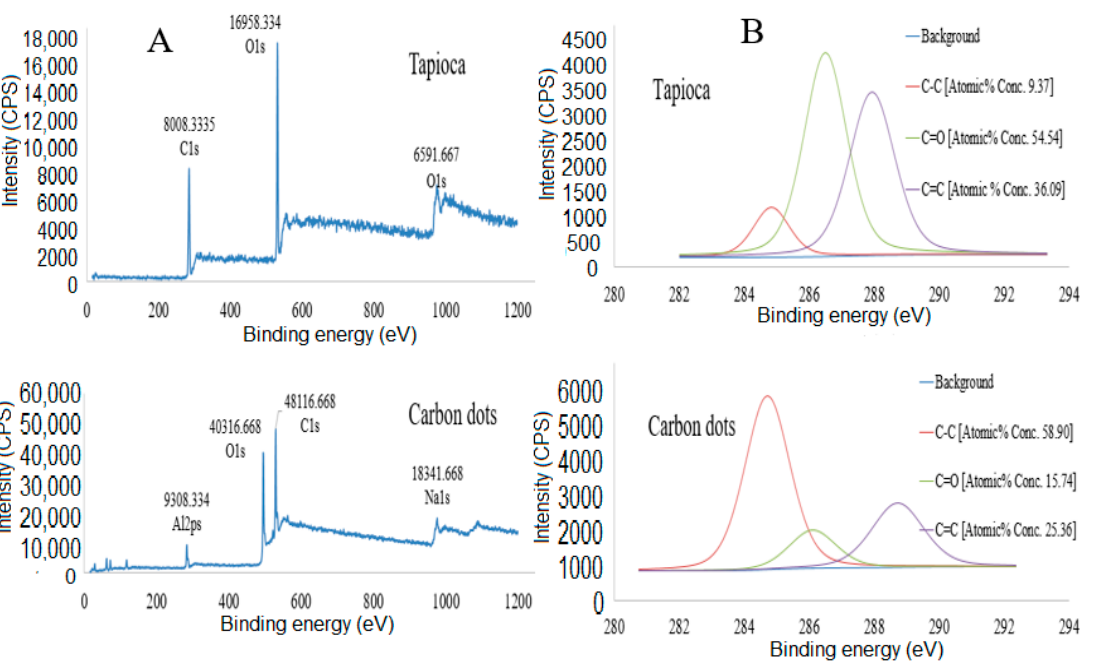
Figure 4. ( A , B ); Wide and narrow scan for tapioca (precursor) and synthesized carbon dots. Figure 4. ( A , B ) Wide and narrow scan for tapioca (precursor) and synthesized carbon